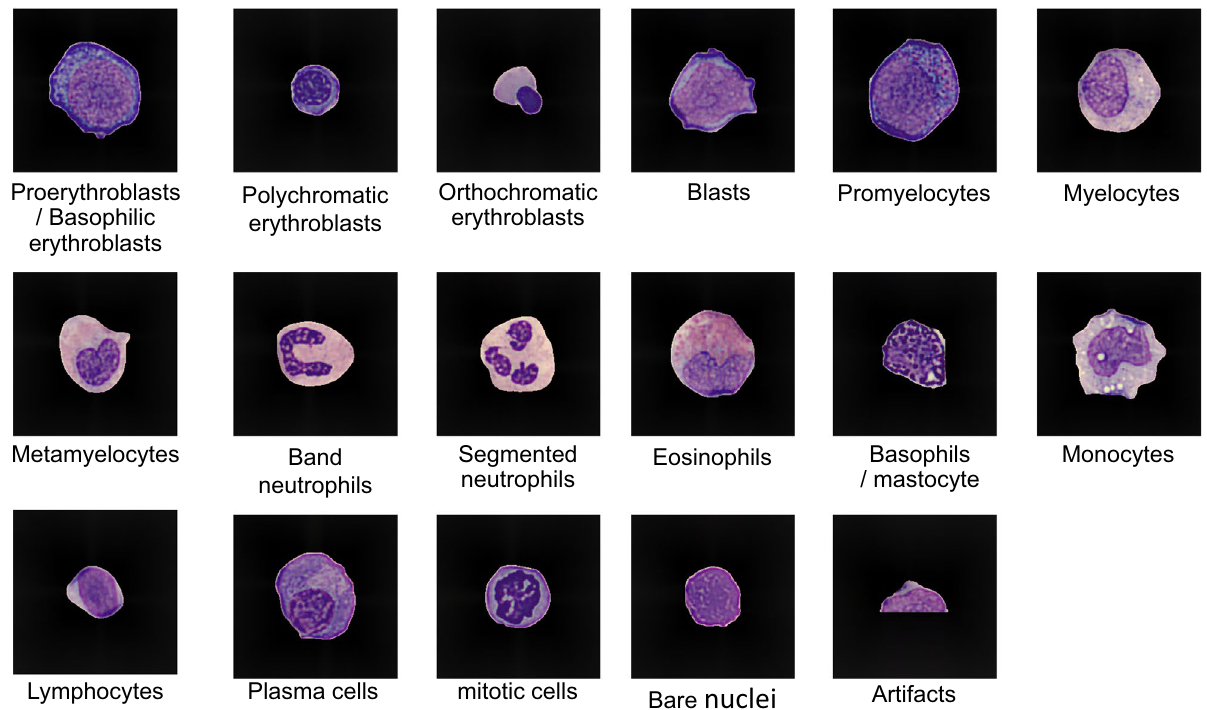
Figure 5. Flowchart from blood films to image data. The inverted trapezoidal frame shows manual processing. The rectangular frame shows automatic processing or processing by hand-made programs written in Python and Cellavision DM96. PEP/BEB: proerythroblast/basophilic